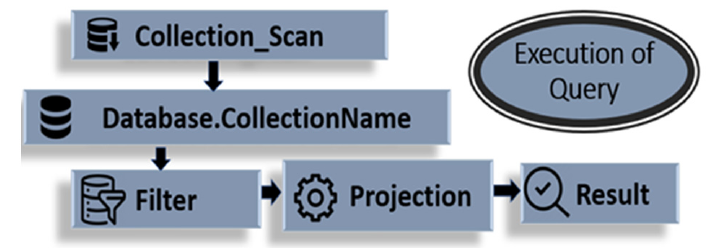
Figure 3. Execution flow of Pseudocode 1 and Pseudocode 2.